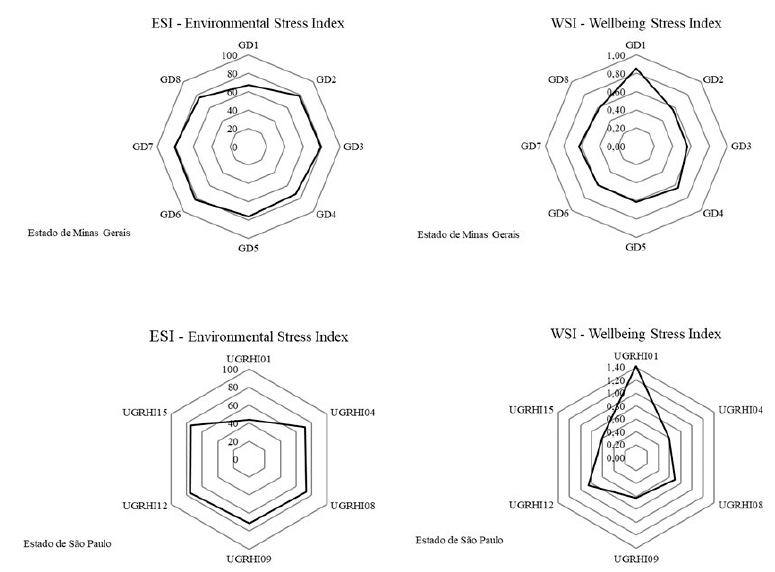
Figure 6. Environmental Stress Index and Well-being Stress Index for the BHRG water management units.